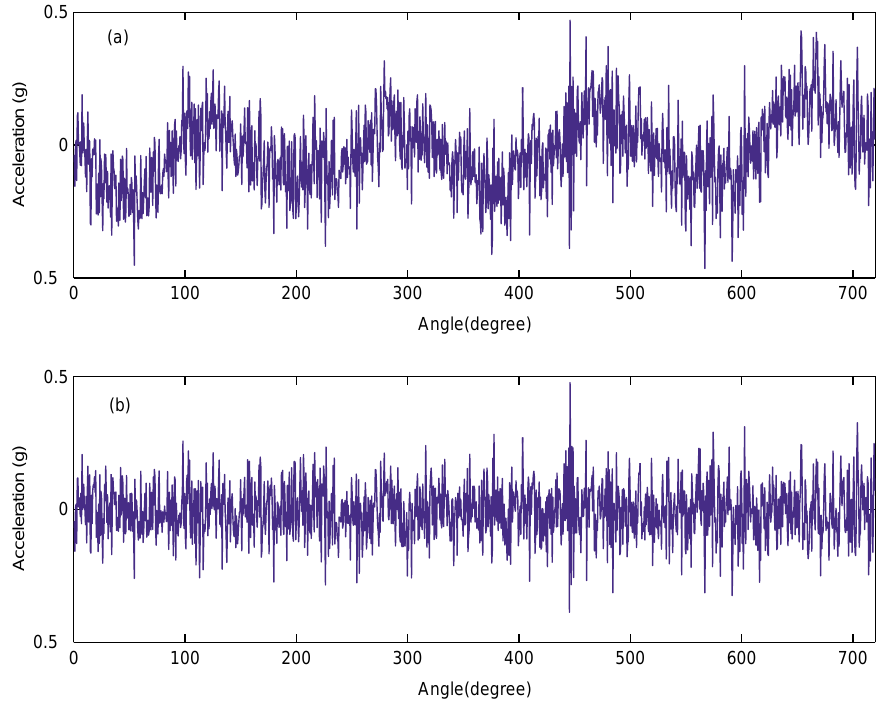
Fig. 6. Results of enhancement for measured data from an automotive engine with abnormal condition of valve system. (a) Time series data. (b) Enhanced data after two stage